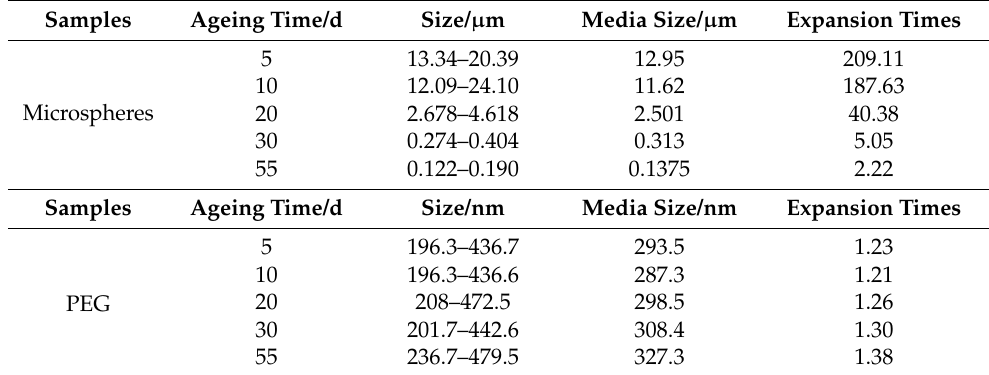
Figure 10. Particle size distribution diagram of the microspheres and PEG. Table 4. Hydration and expansion performance of the microspheres and